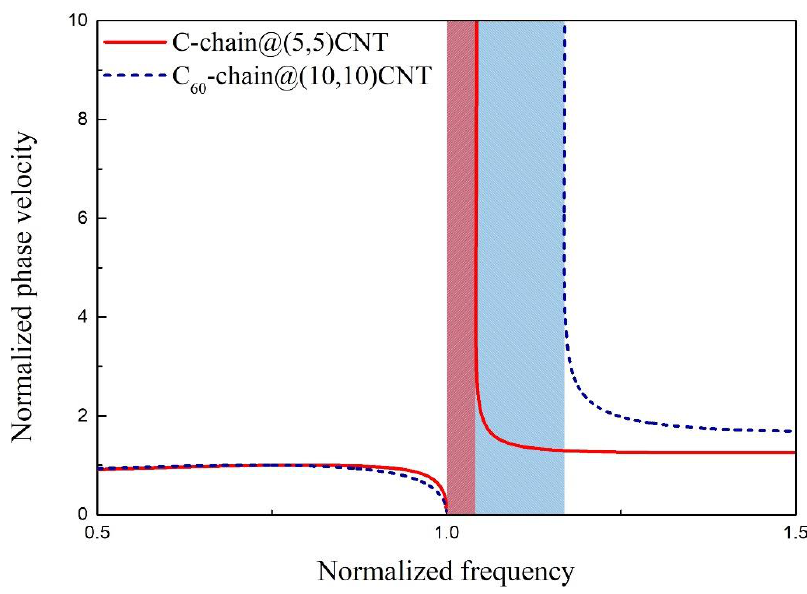
Figure 8. The normalized phase velocity versus the normalized wave frequency of the CCSC and the C60 chain-filled SWCNT. The rectangular shadow in red and blue represents the bandgap of the CCSC and the C60 chain-filled SWCNT, respectively.